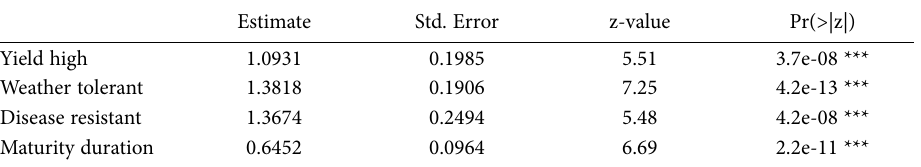
Table A-2. Standard deviations of the random parameters from mixed logit model results.